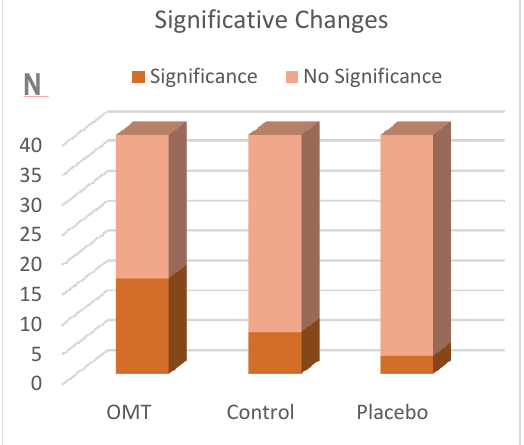
Figure 3. Number of subjects that presented significative variations of their muscular activity between T0 and T2.